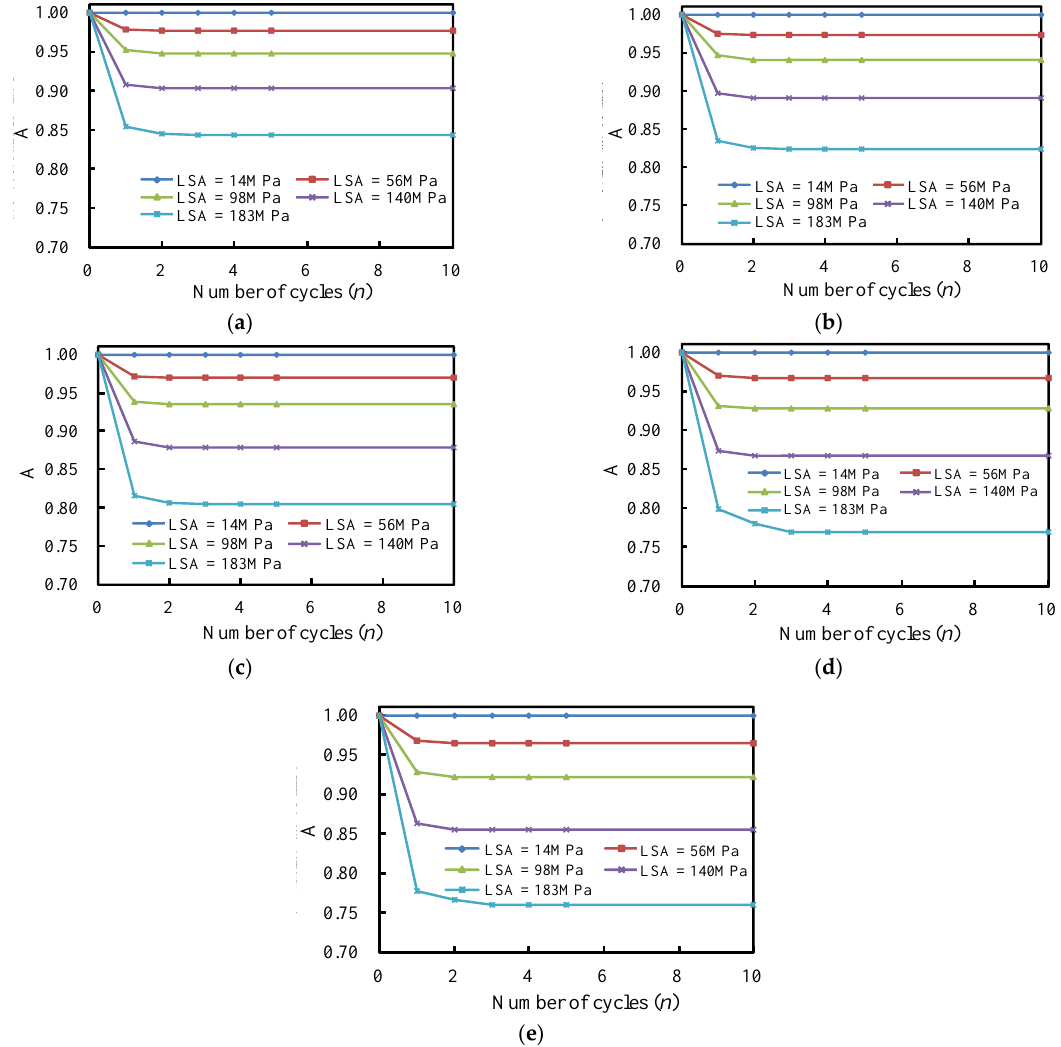
Figure 17. The variation curve of residual stress relaxation coefficient A with LSA: ( a ) R = ‒0.5; ( b ) R = ‒0.25; ( c ) R = 0; ( d ) R = 0.25; ( e ) R = 0.5.